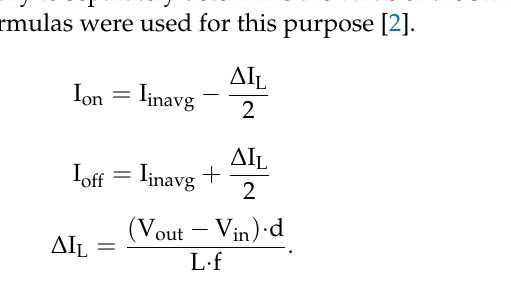
Figure 9. Measured and computed dependences of the output voltage on the duty cycle of the boost converter for selected values of load resistances.